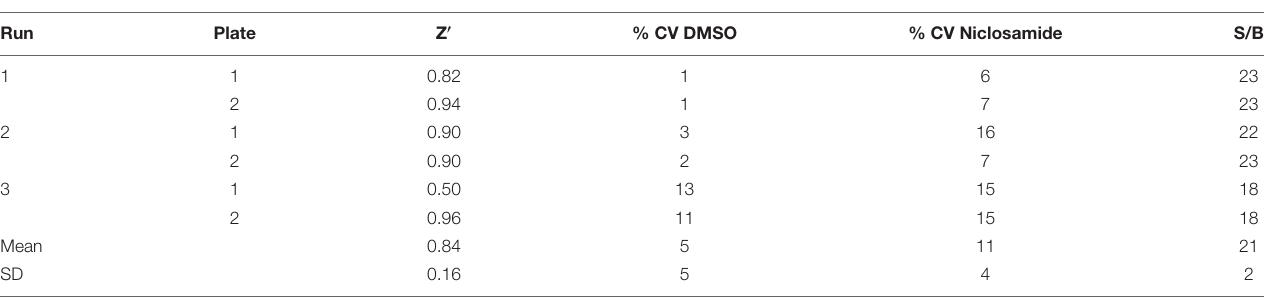
FIGURE 5 | Validation of high-throughput screen. (A) Metabolic activity measured by alamarBlue R (cid:13) turnover was plotted for individual plates from each of two separate biological runs. (B) Activity of niclosamide was determined in 16 technical replicates across two different plates. Line of best fit was plotted by the Gompertz equation. Data are representative of three independent biological replicates. TABLE 2 | Assay reproducibility and robustness